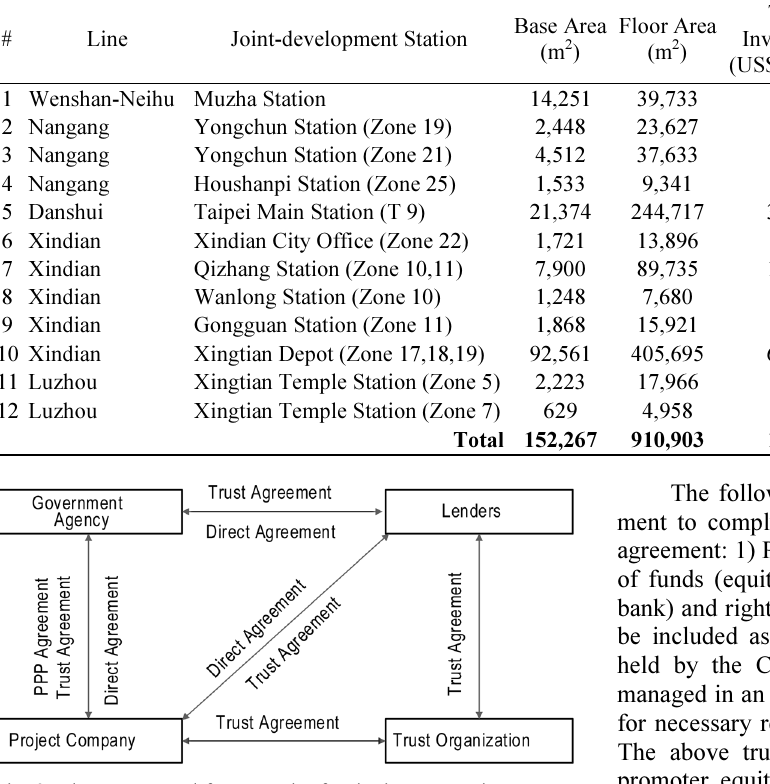
Fig. 2. The contractual framework of Taipei MRT station PPP